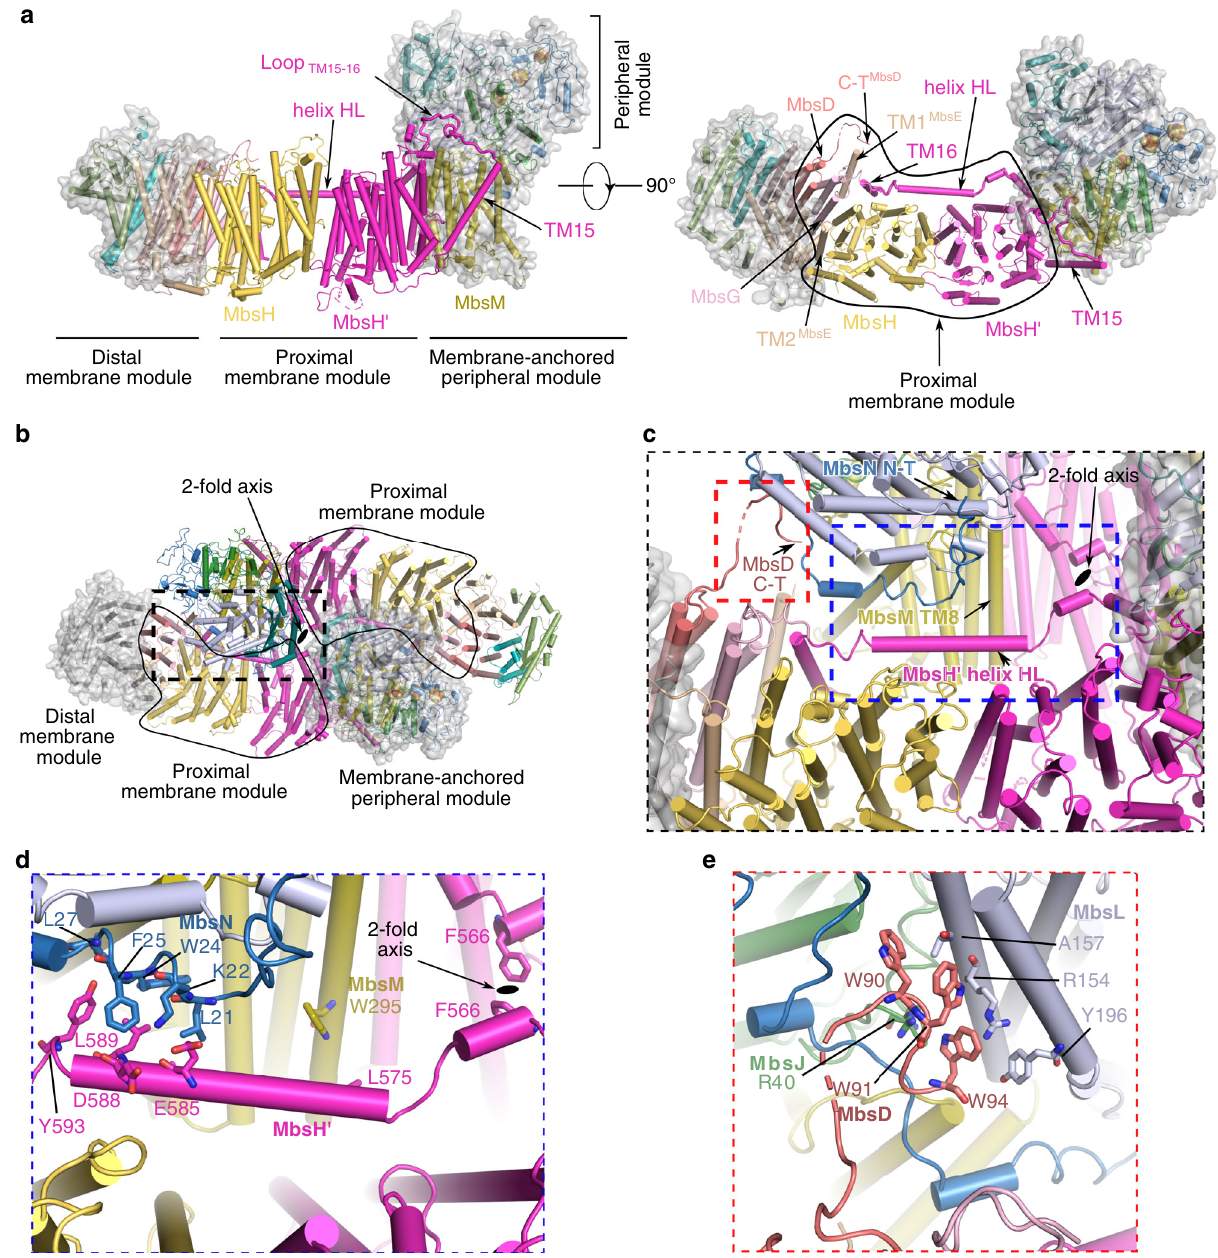
Fig. 2 The architecture of the dimeric MBS complex. a Side (left) and top cytoplasmic views (right) of an MBS monomer. The central proximal membrane module is fl anked by the distal membrane module and the membrane-anchored peripheral module, which are further highlighted by transparent surface views. b A top view showing the assembly of the dimeric MBS complex with the three different modules indicated as in ( a ). c A zoomed view of the dashed rectangle in ( b ). The dimer interface is composed of two regions, one involving the Helix HL of MbsH ’ (dashed blue box) and the other involving the elongated C-terminal tail of MbsD (dashed red box). d A close-up view of the dashed blue box in ( c ). e A close-up view of the dashed red box in ( c ). Residues contributing to the dimer interface are shown as sticks in ( d ) and ( e